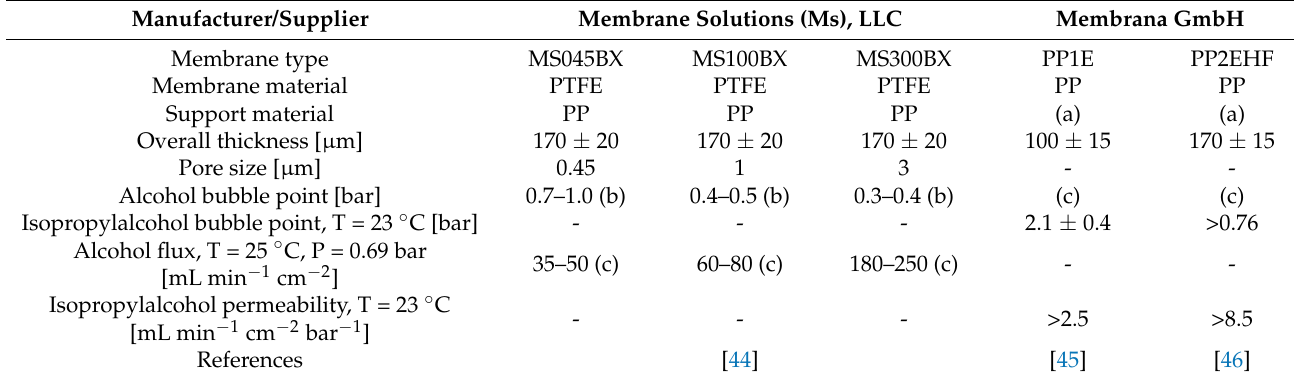
Table 1. Main properties of the membranes used for VMD tests.